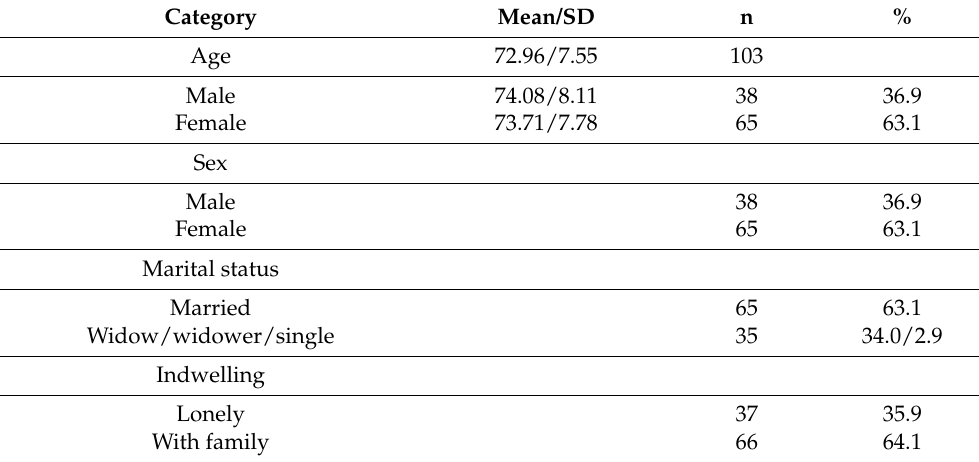
Table 1. Socio-demographic and clinical characteristics of the study group (n =